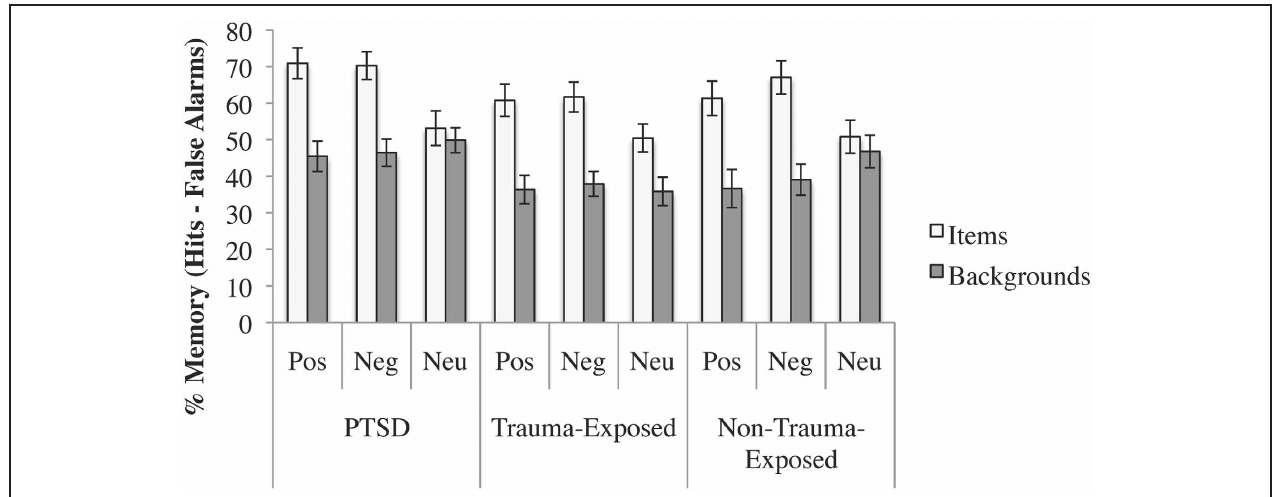
FIGURE 3 | Item and background memory for scenes that included a positive, negative, or neutral